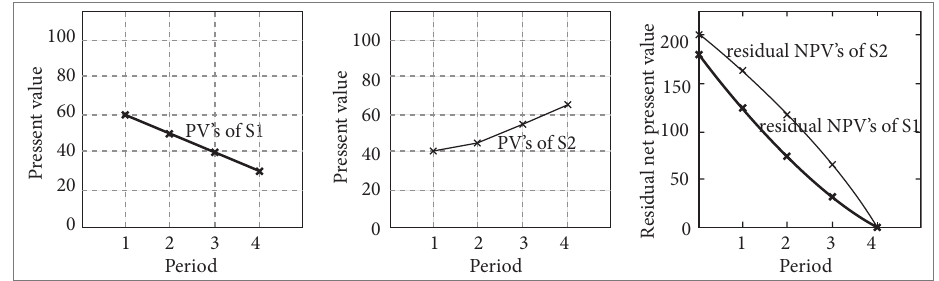
Fig. 4. Ideal-typical example of low agent switching costs and private information about the suppliers’ maximal bids, present values of both suppliers (left, middle) and comparison of residual net present values (right)